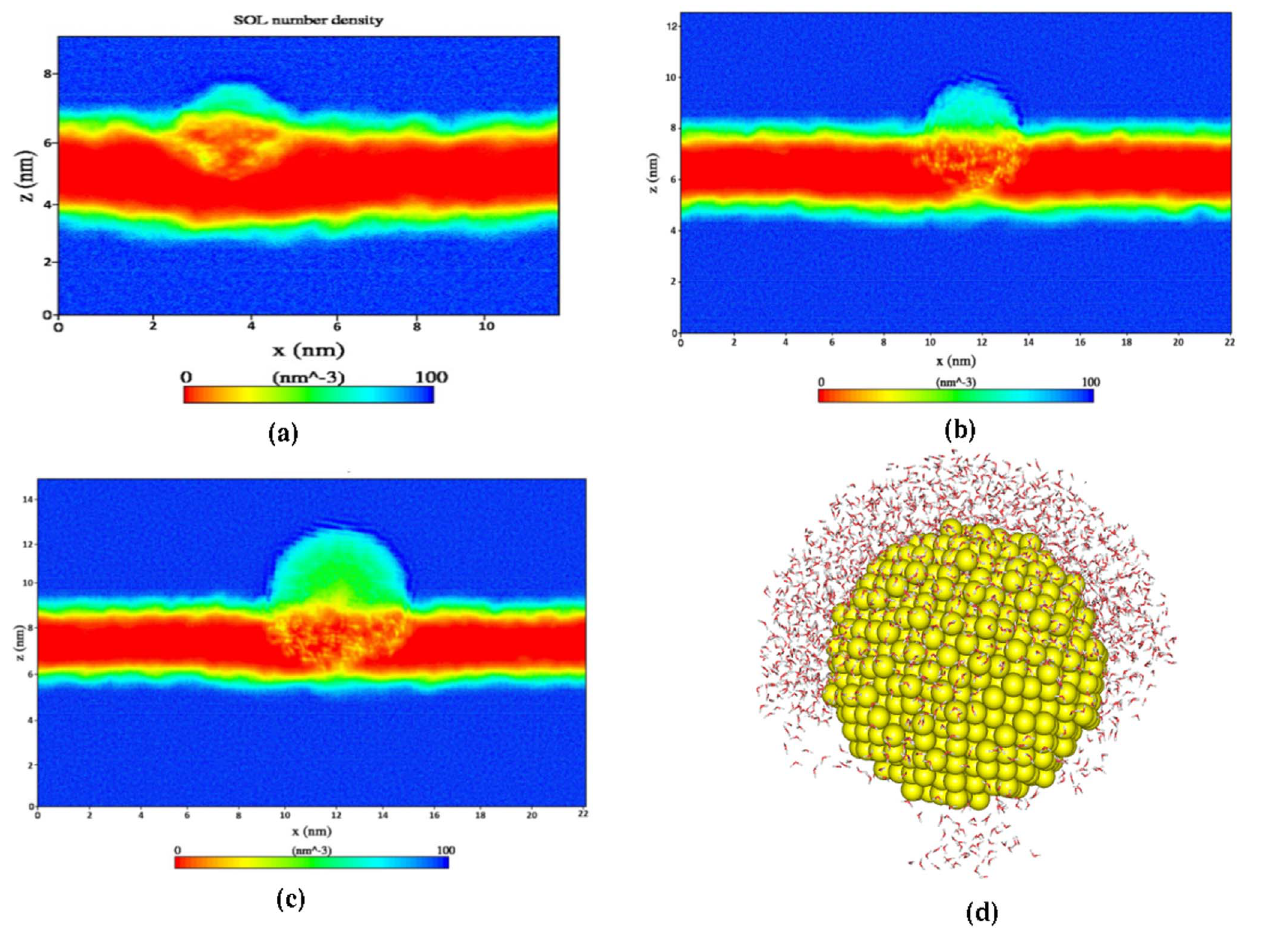
Figure 4. Two dimensional density map of water. (a), (b), and (c) represents systems 2 nm_AuNP, 3.5 nm_AuNP and 5 nm_AuNP respectively (d) schematically shows the water density around the AuNP upto certain cutoff (bilayer not